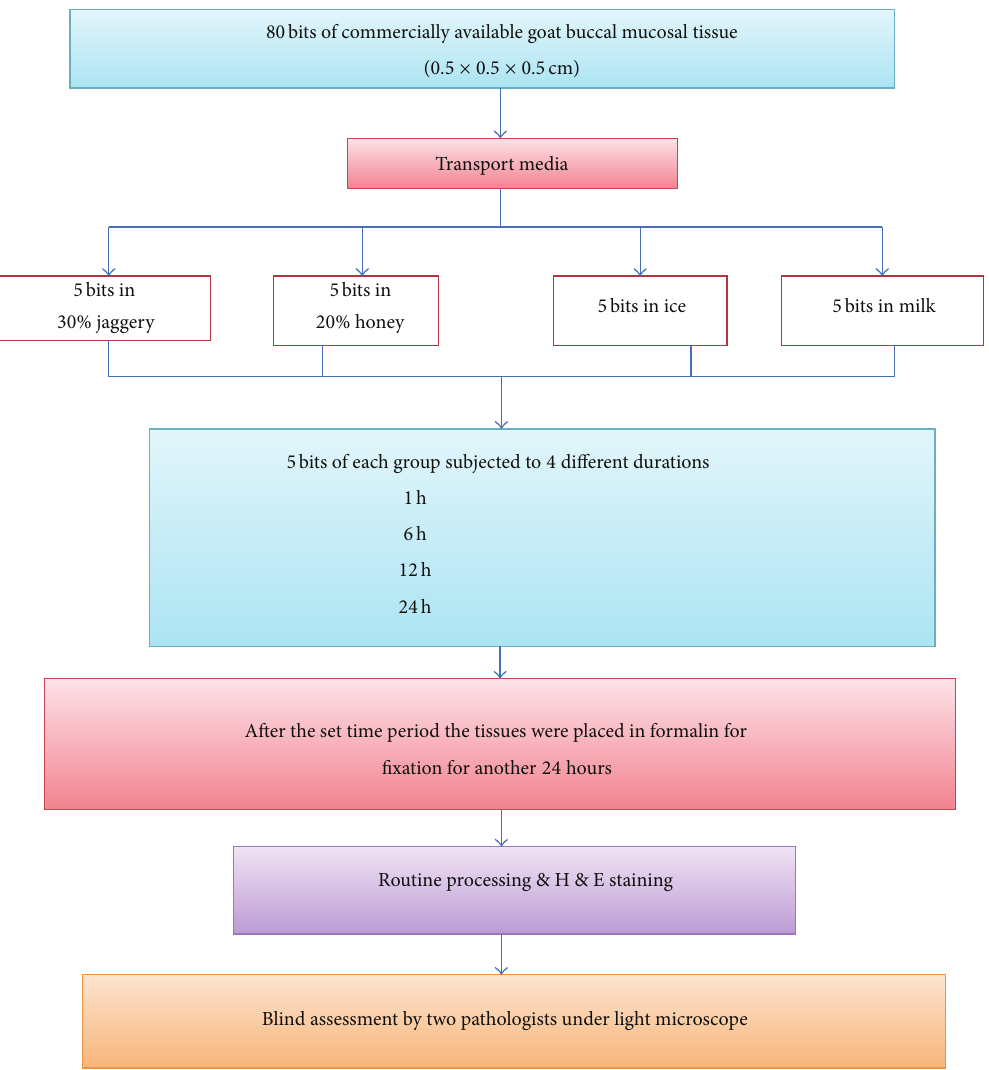
Figure 1: Flowchart representing the protocol employed in the study.